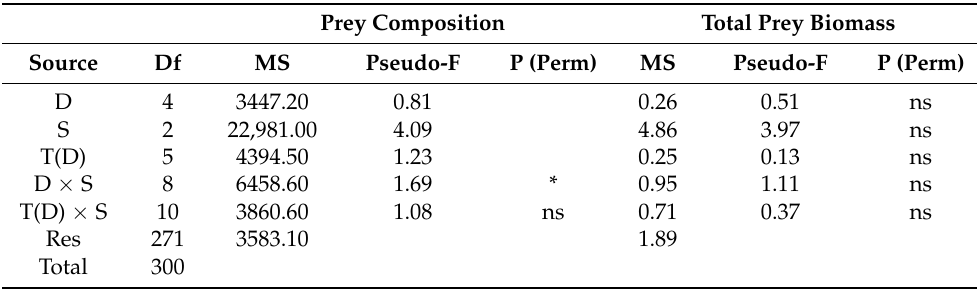
Table 6. Results of the pairwise tests contrasting the prey compositions of polyps of the three species